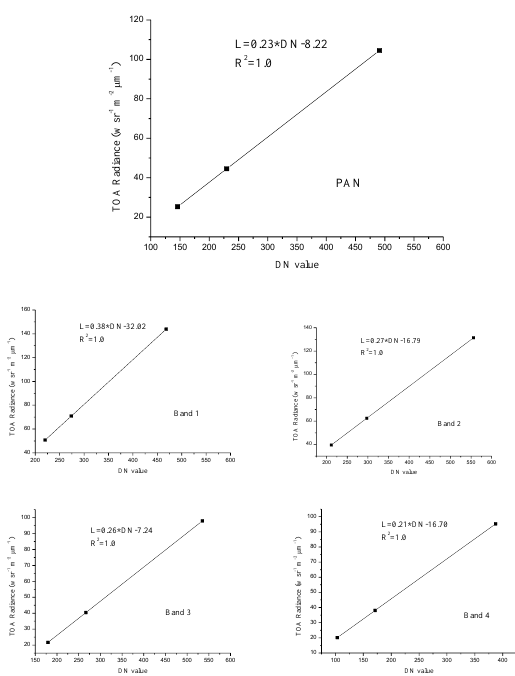
Figure 14. Radiometric calibration result of GF-1 panchromatic and multi-spectral sensors